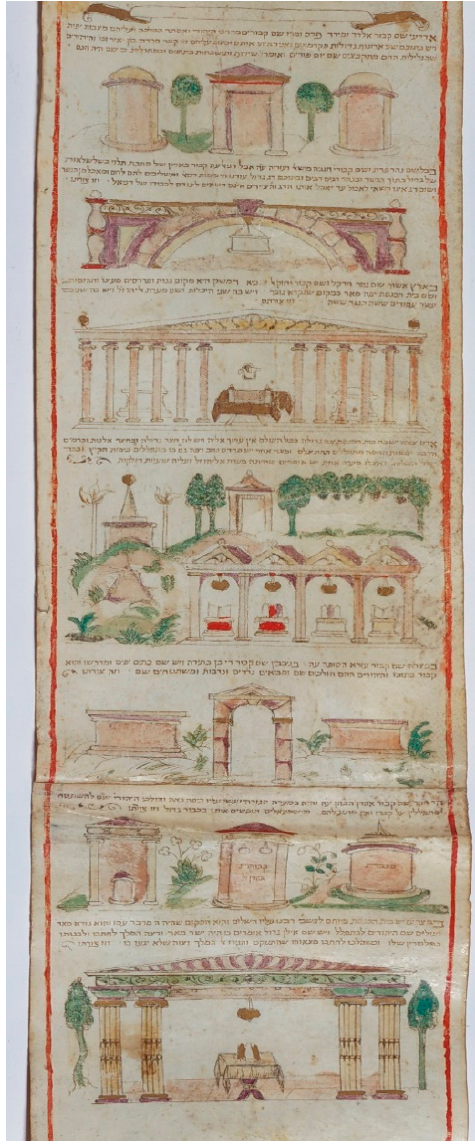
Figure 8. Jerusalem, National Library, The scroll of Yihus ha-Avot from Italy, 16th century, Ms. Heb. 28.2370, used with permission from the National Library of Israel.